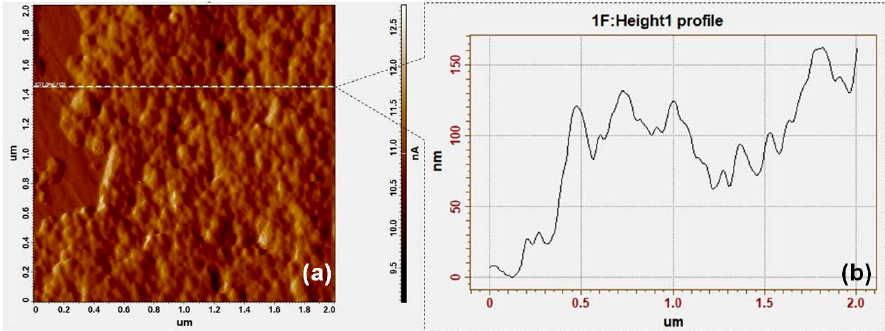
Figure 3. Topographic Atomic Force Microscopy (AFM) image of the solid plasmonic nanosilver substrate ( a ). Height profile of the substrate ( b ).